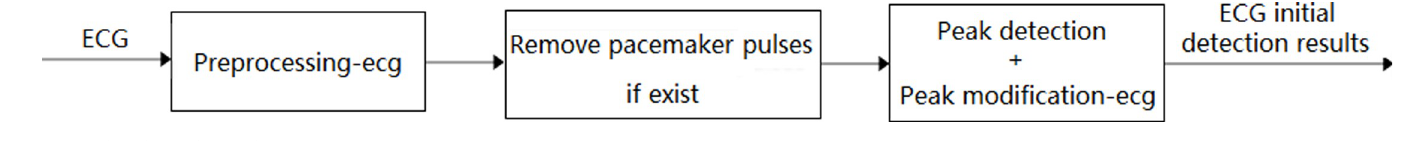
Fig 4. Flowchart of ECG detection.